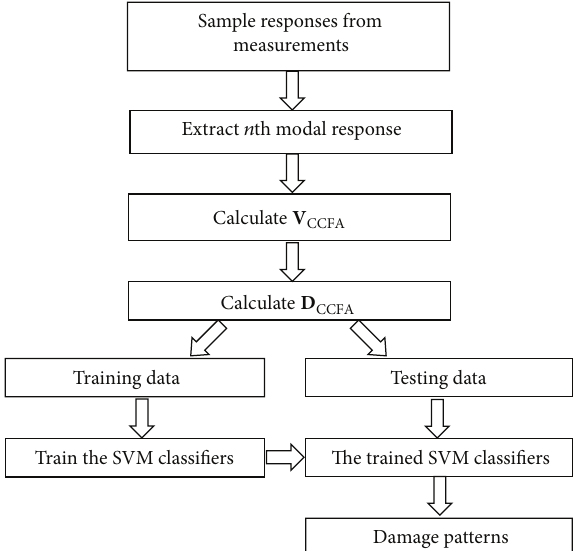
Figure 3: Overall procedure of proposed method.